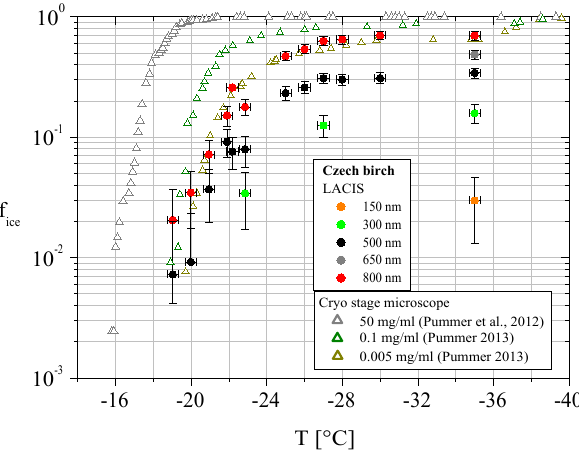
Fig. 2. Ice fraction f ice as a function of temperature T for 150, 300, 500, 650 and 800nm Czech birch pollen washing water particles. The filled squares show the LACIS data and the triangles are mea- surements done by Bernhard Pummer with a cryostage microscope (Pummer et al., 2012, Pummer, 2013).